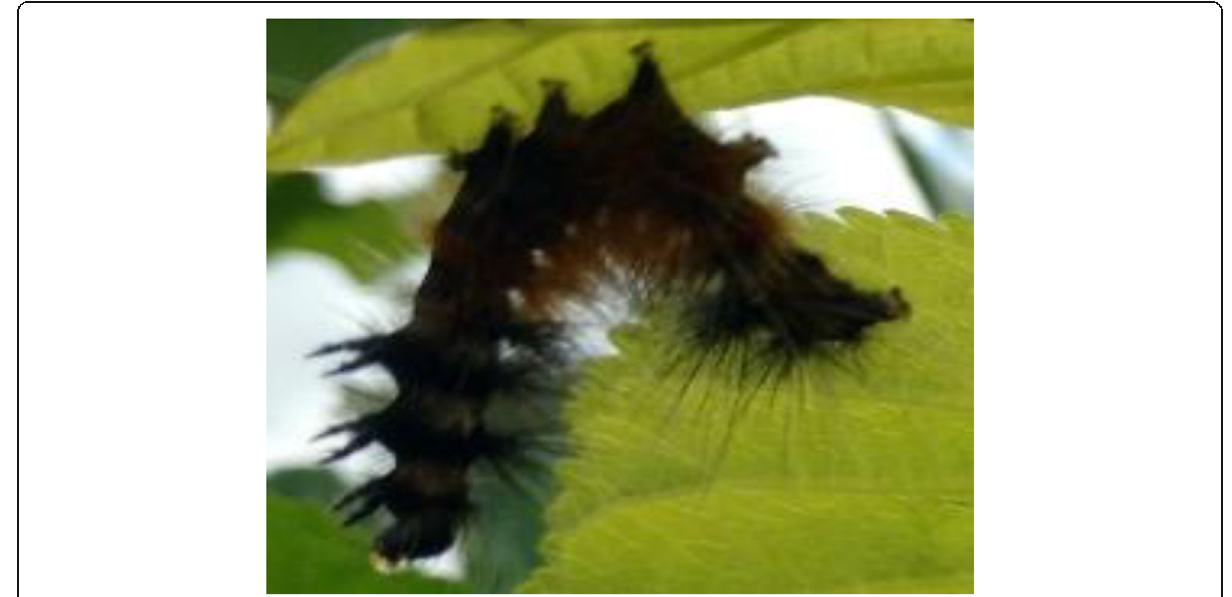
Fig. 1 Spilosoma obliqua larva showing characteristic signs of NPV